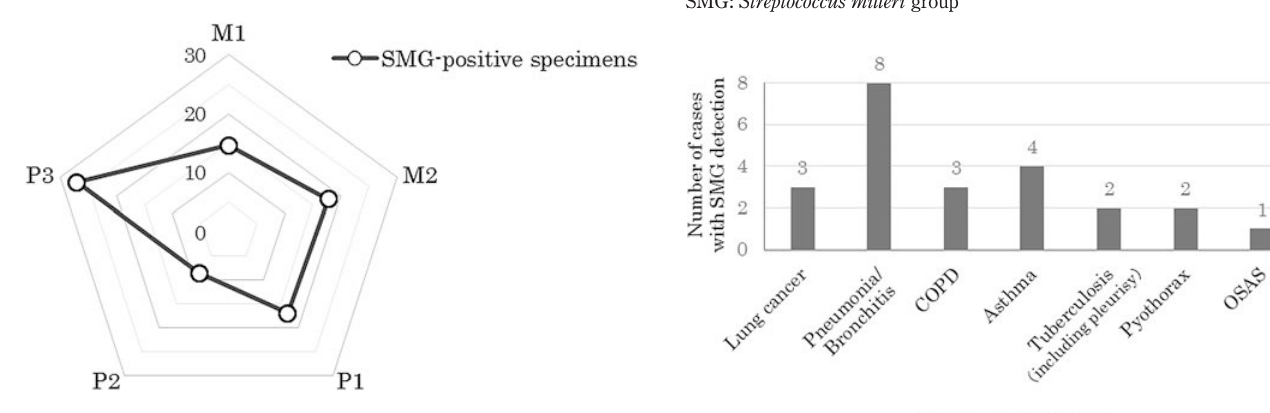
Figure 2 Sputum type of SMG-positive specimens according to the Miller and Jones classification system Each spoke on this radar chart represents a sputum type in the Miller and Jones classification system. The solid line indicates all SMG-positive specimens. SMG bacteria were most frequently detected in P3 sputum (27 samples).